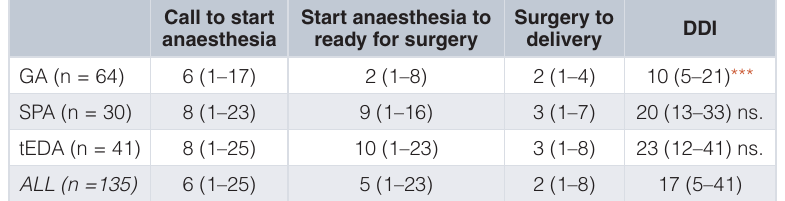
Table 1. Time events for different anaesthetic techniques. Data are presented in minutes as median